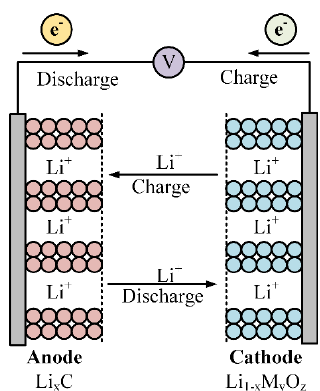
Figure 25. Charge and discharge cycles of a typical Li-ion battery; the anode consists of lithiated metal oxide and the cathode consists of graphitic carbon with a layering structure [96].